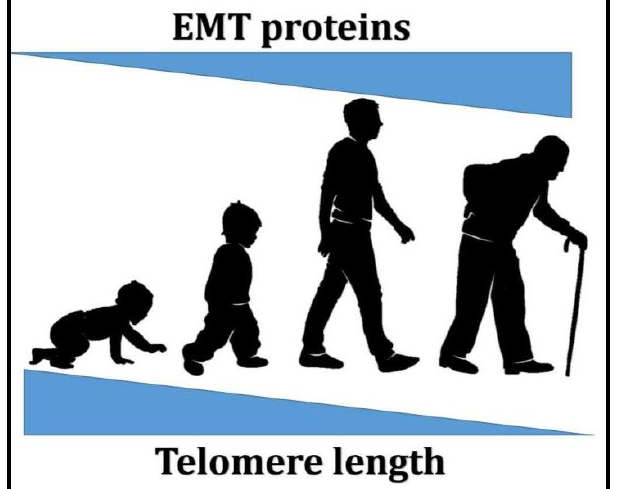
Figure 1. A schematic representation of the relationship between aging, telomere length, and epithelial–mesenchymal transition (EMT)-associated proteins levels.